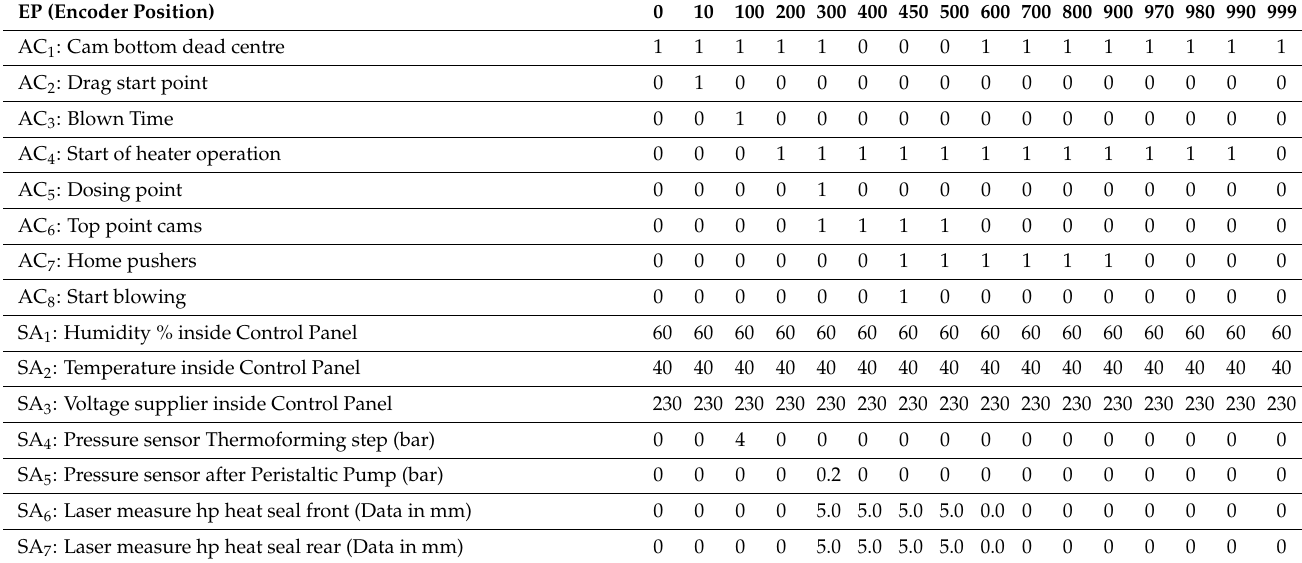
Table 5. Normal pattern of behaviour of multi-stage thermoforming